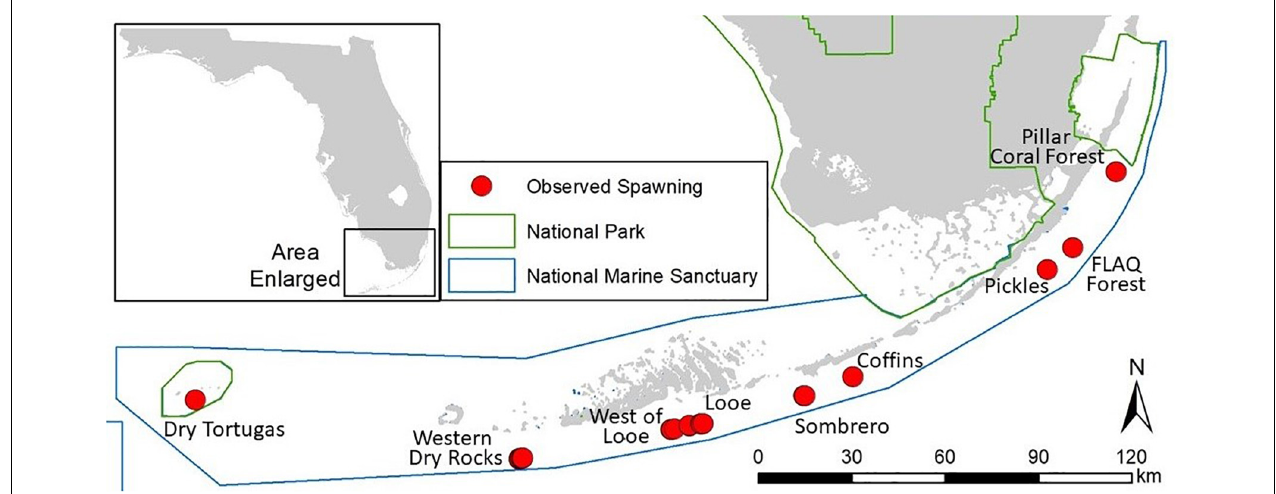
FIGURE 1 | Locations of 26 in situ Dendrogyra cylindrus genotypes observed spawning between 2012 and 2019 on the Florida Reef Tract.